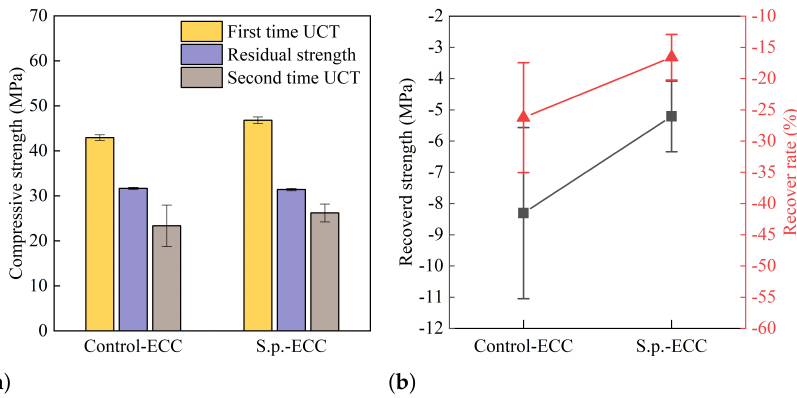
Figure 9. Strength recovery of ECC samples at Standard cured (28 days). ( a ) Compressive strength for repeated compression tests. ( b ) Strength recover